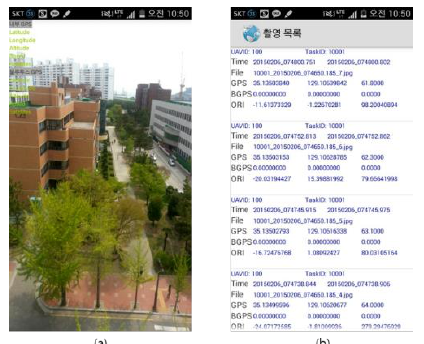
Figure 4. Automatic shooting module screenshots. (a) Automatic shooting (b) shooting